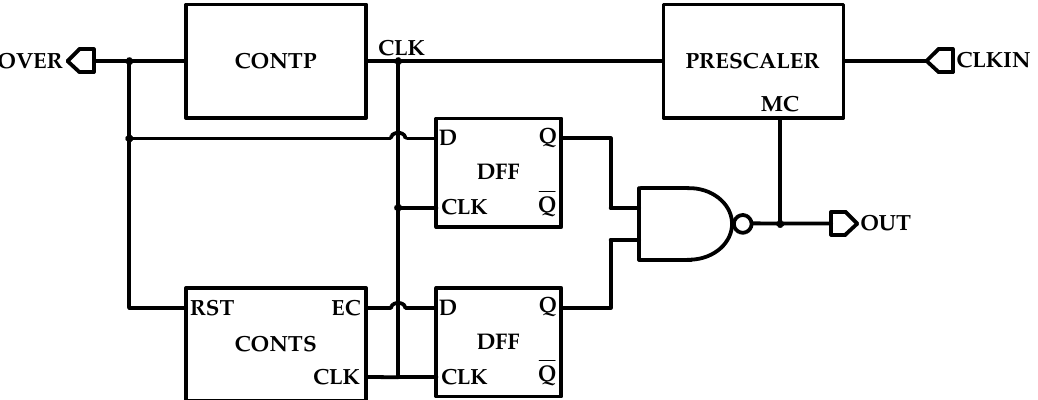
Figure 3. The structure of the pulse-swallow MMD.